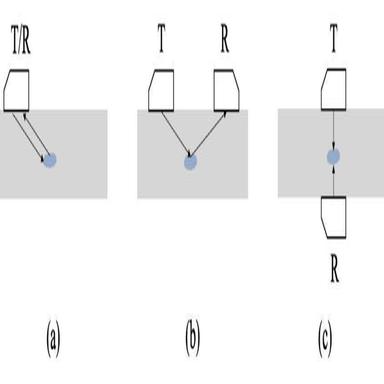
A-scan, B-scan, and C-scan inspection using a pulse-echo UT configuration.